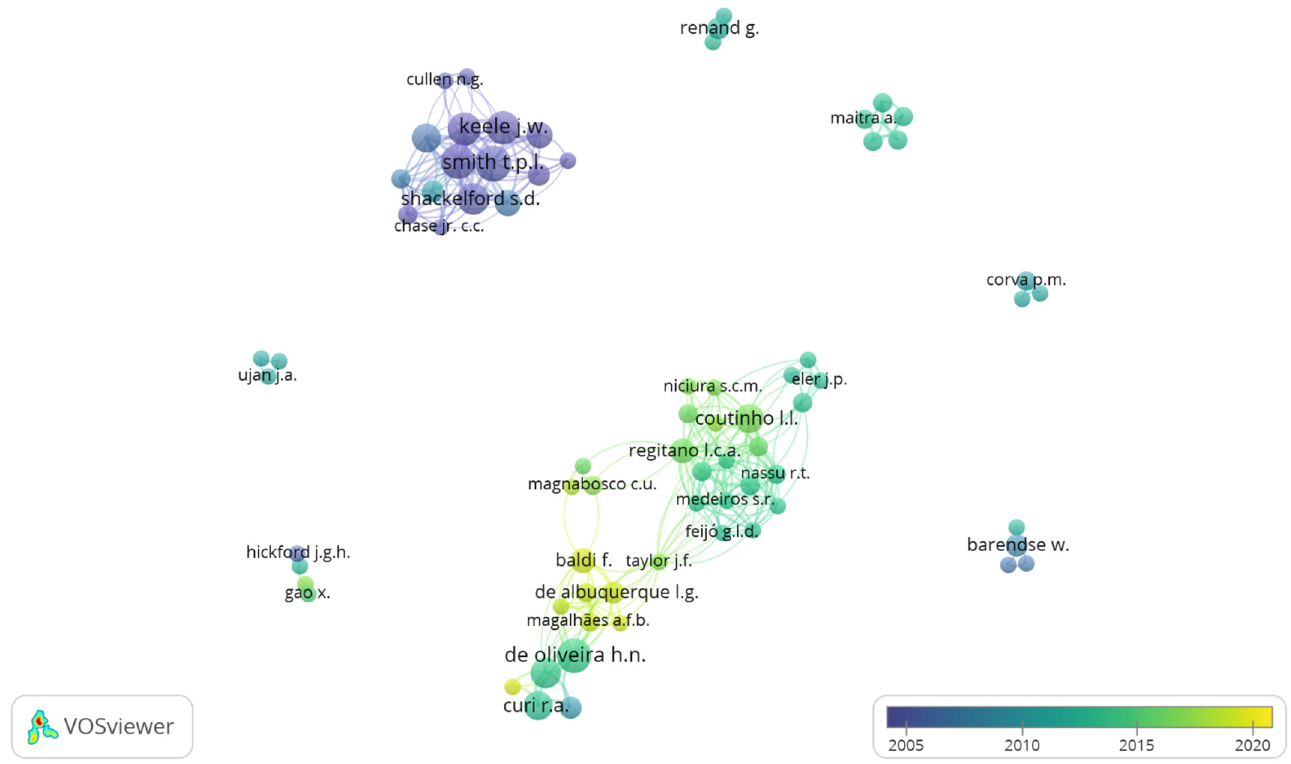
Figure 2. Overlay visualization network of the top 73 authors in the field.